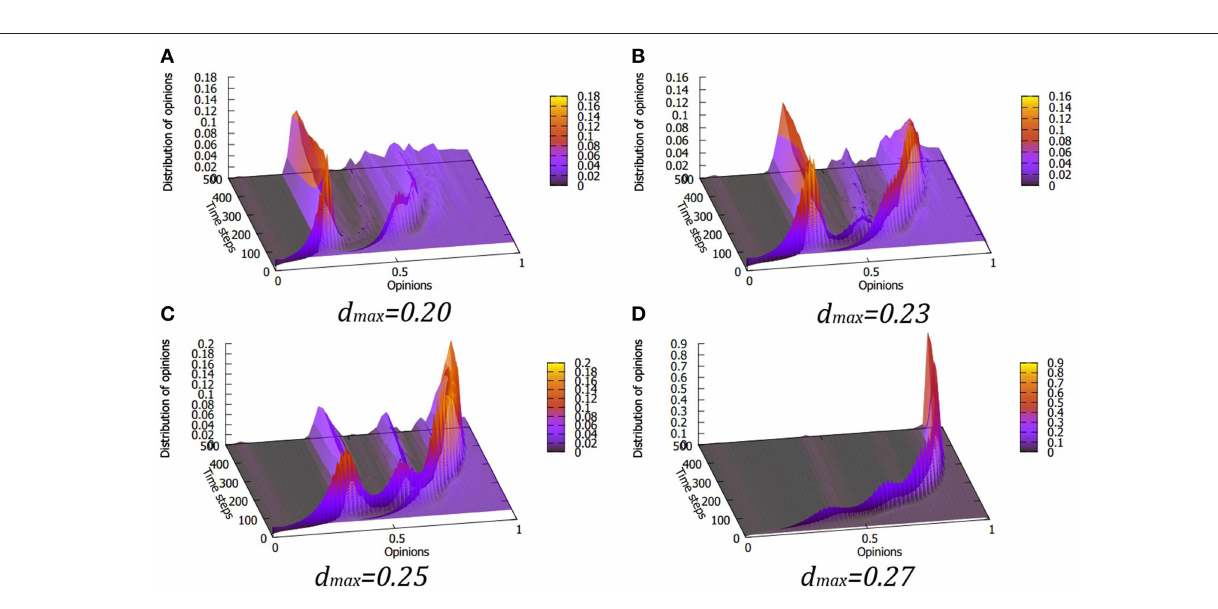
of the spectrum [ − 1: + 1]. Such an evolution, squeezing